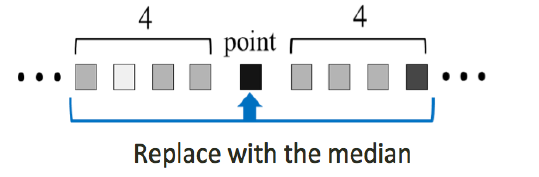
Figure 8. Median filter on scan line